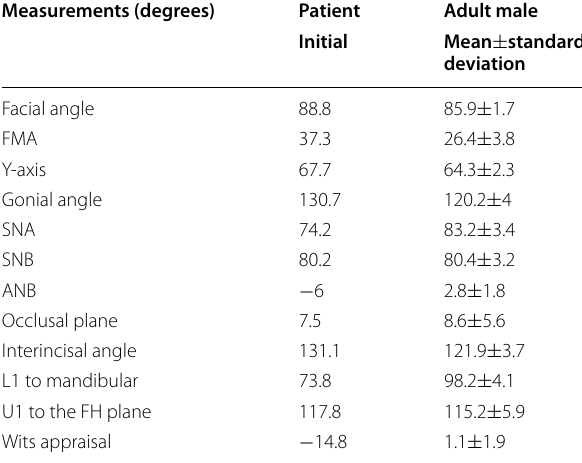
FMA Frankfort–mandibular plane angle, SNA sella/nasion plane and nasion/A plane angle, SNB sella/nasion plane and nasion/B plane angle, ANB A point– nasion–B point, FH Frankfort horizontal